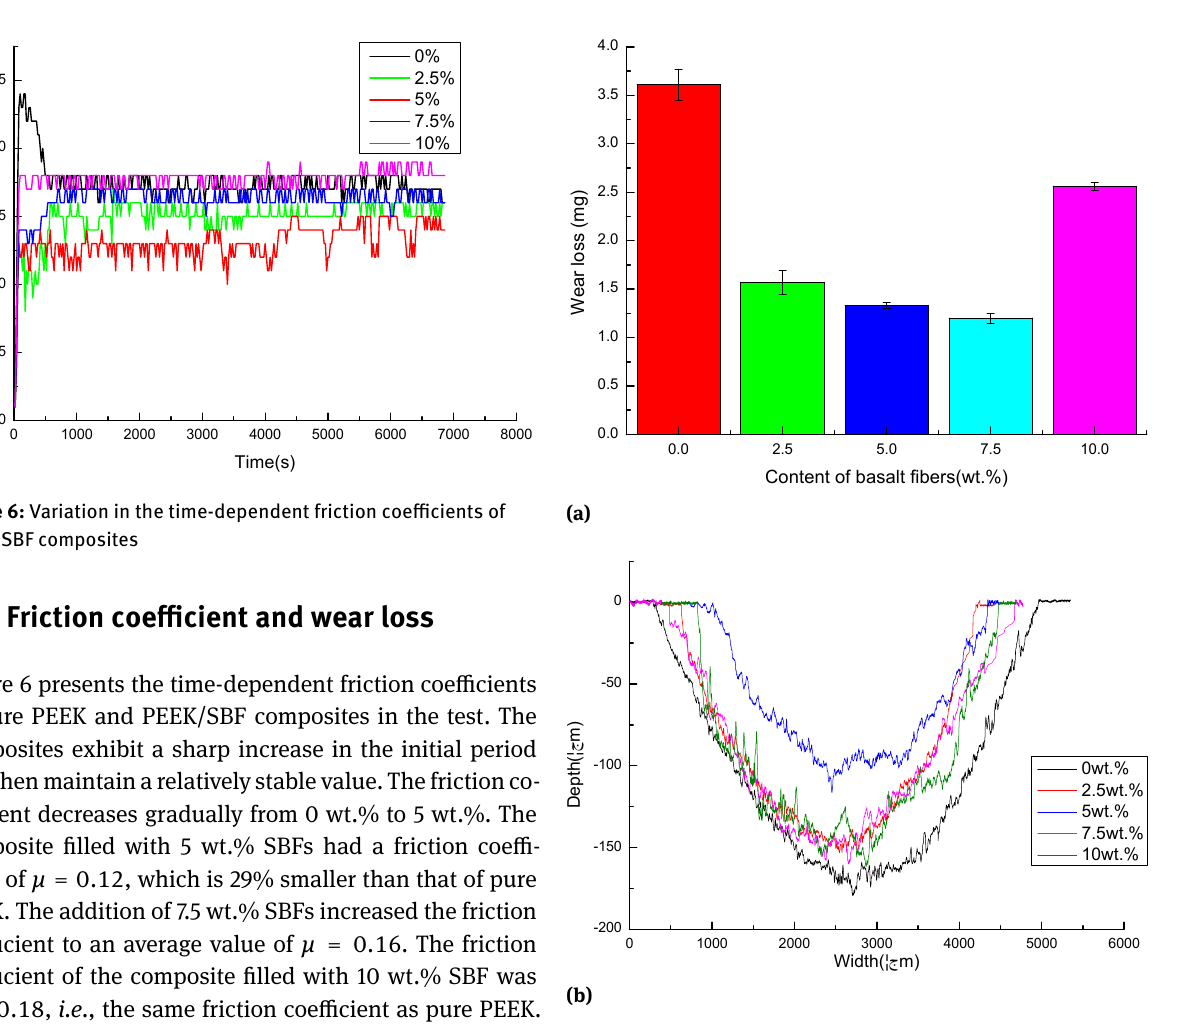
Figure 7: Variation in the wear loss and shape of the section for PEEK and PEEK/ SBF composites (a) wear loss of PEEK/SBF compos- ites (b) section contours of PEEK/SBF composites Table 3: Wear width and wear depth of PEEK/SBF